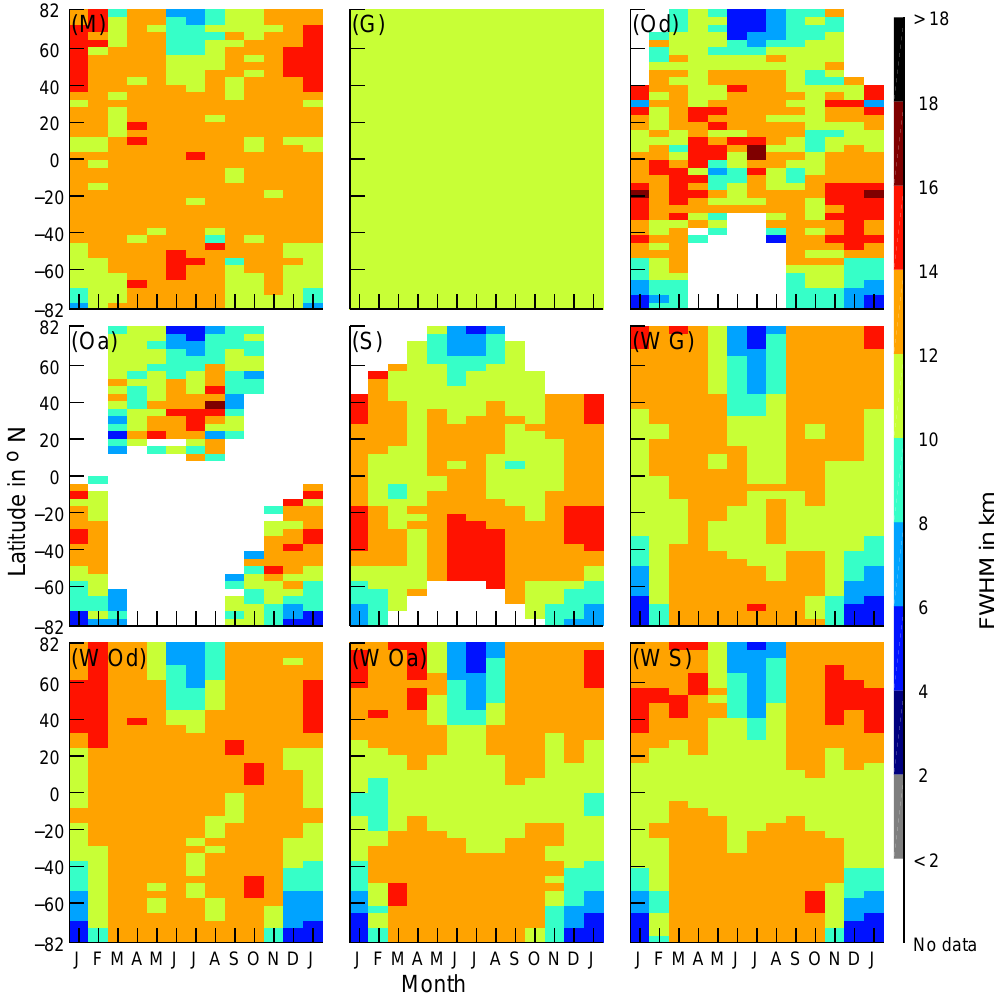
Figure 8. 2008–2012 multi-annual monthly mean Na layer full width at half maximum from different instruments and models. Ensemble mean (M), GOMOS (G), OSIRIS descending leg (Od), OSIRIS ascending leg (Oa), SCIAMACHY dayglow (S), WACCM colocated with the LT of ascending leg of GOMOS (W G), WACCM colocated with the LT of the descending leg of OSIRIS (W Od), WACCM colocated with the LT of the ascending leg of OSIRIS (W Oa), WACCM colocated with the dayglow measurements of SCIAMACHY and the descending leg of GOMOS (W